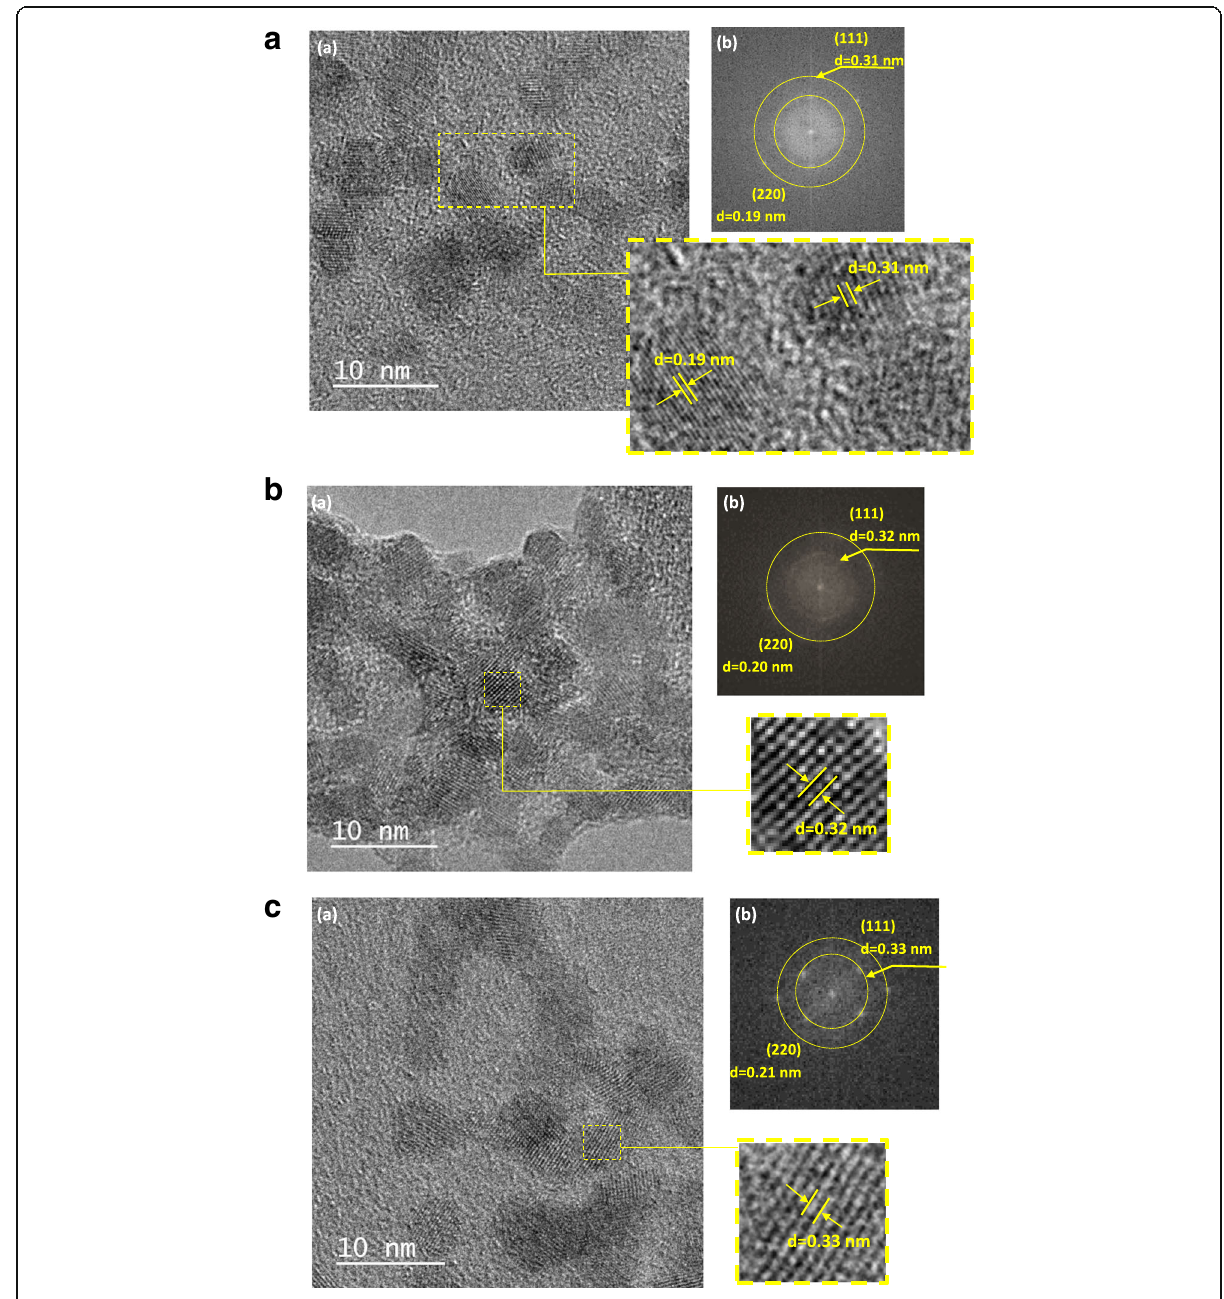
Fig. 4 Transmission electron microscopy characterization of conjugates; (a) TEM image with SAED patterns (detail) and (b) diffraction rings attributed to (111) and (220) planes of the cubic lattice ( d = interplanar distance) for a ZnS, b Zn 0.50 Cd 0.50 S, and c CdS